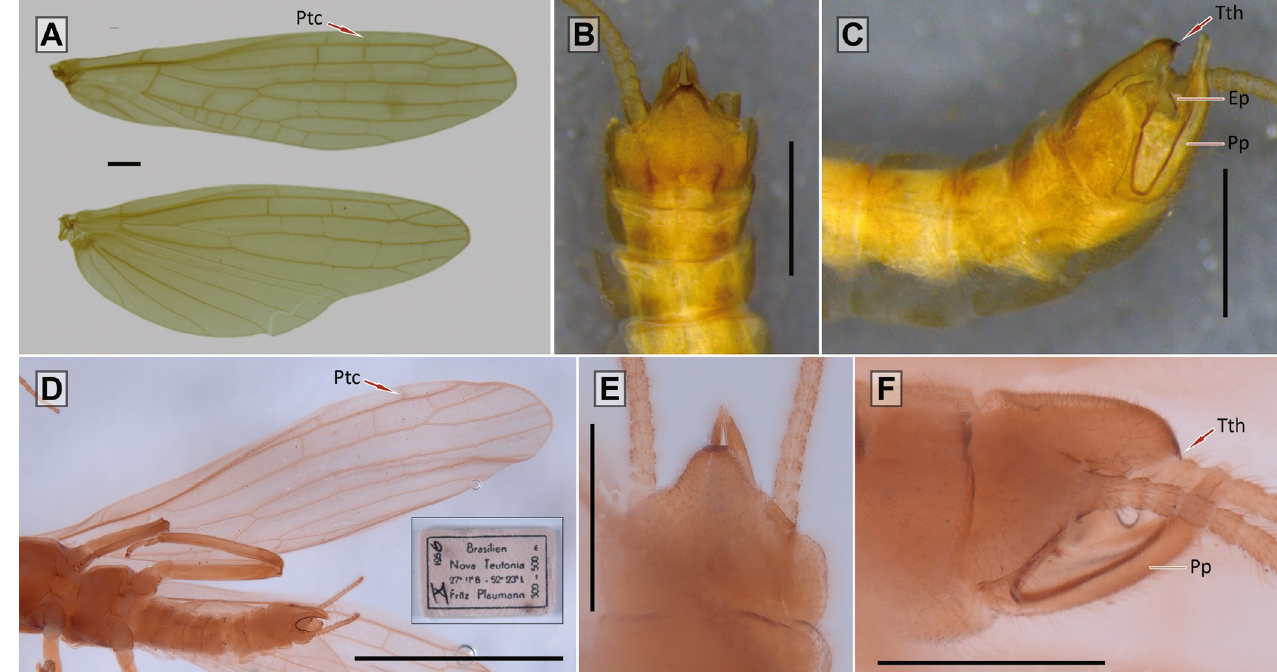
Fig 4. Morphological characters of Paragripopteryx klapaleki . Paragripopteryx klapaleki : (A) adult male, fore- and hind wings. (B , C) Male terminalia in dorsal and lateral views, respectively. Paragripopteryx crassila : (D) holotype adult male, detail of forewing. (E , F) Male terminalia in dorsal and lateral views, respectively (Scale bars: A, B, C, E, F: 0.5 mm; D: 2.0